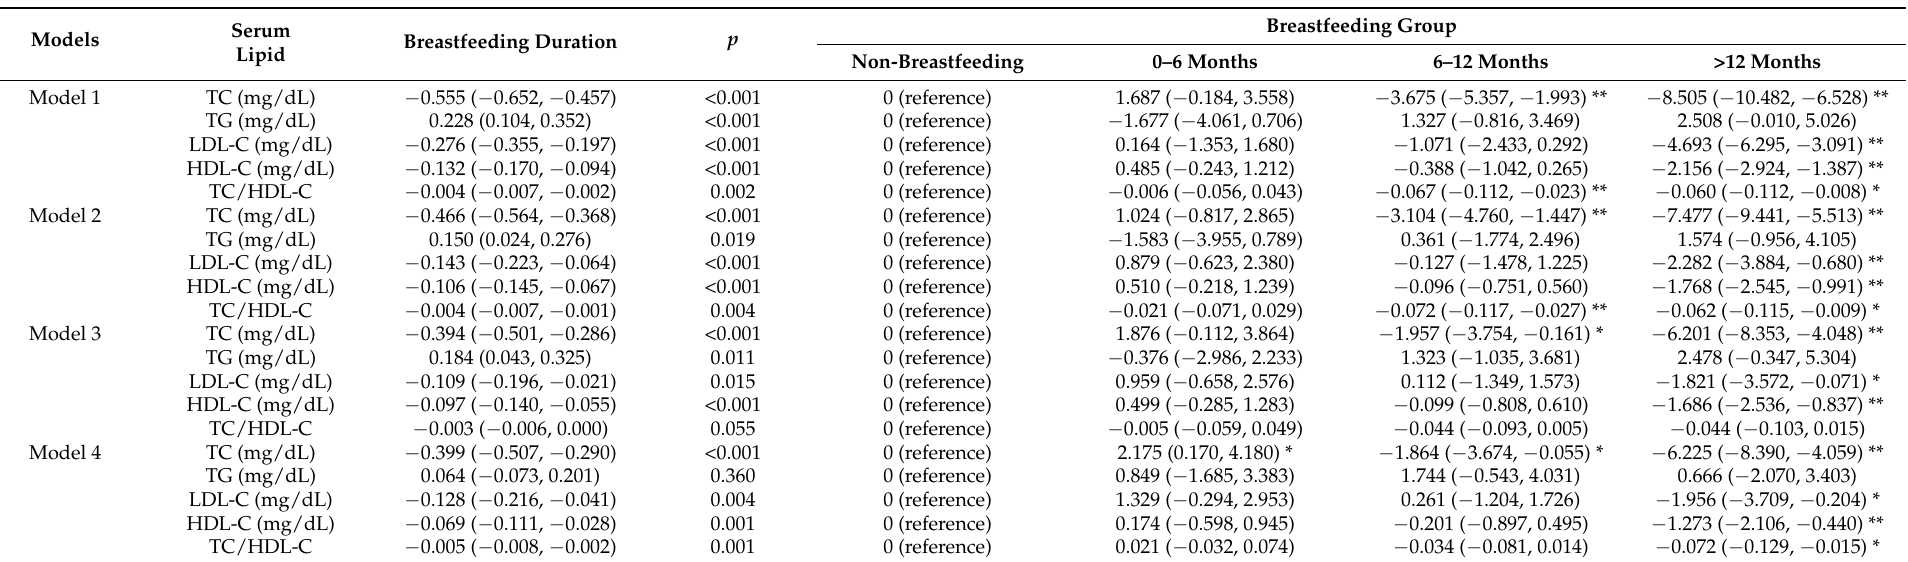
Table 2. Multiple linear regression analysis of breastfeeding duration and lipid levels, β (95%